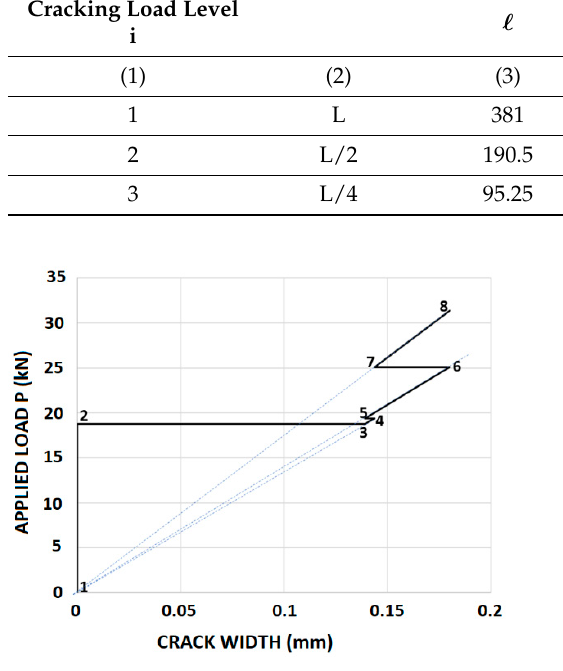
Figure 6. Variation of crack width.